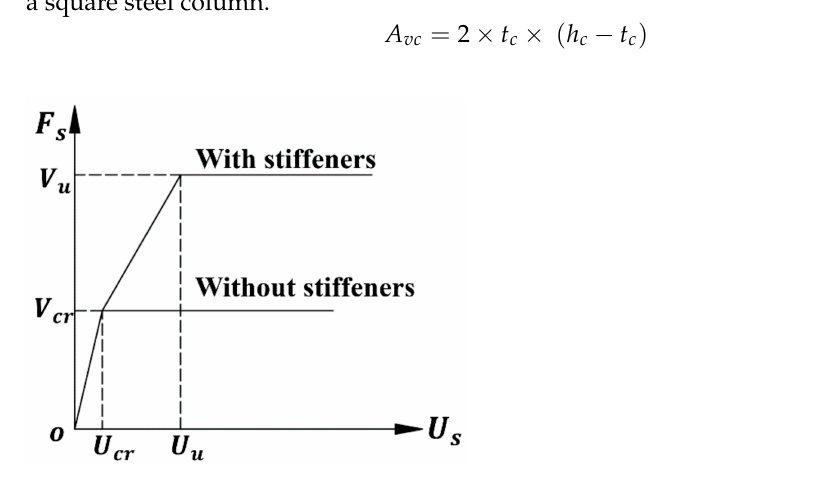
Figure 32. Shear-load-displacement diagram.